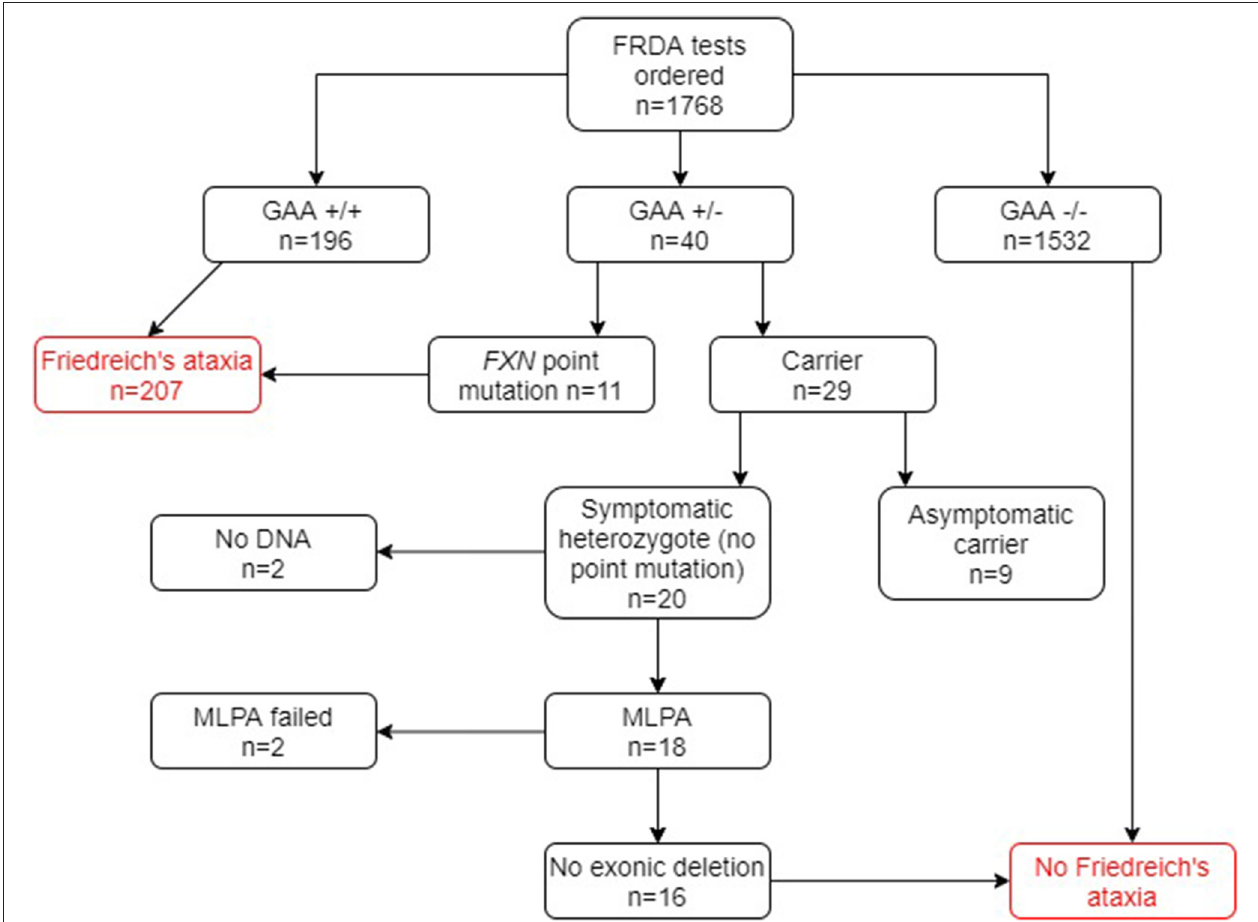
FIGURE 3 | Flowchart summary of genetic results in group B patient cohort. Out of 1,768 patients, 207 patients tested positive for FRDA. GAA + / + two GAA expansions; GAA + / − one GAA expansion; GAA − / − no GAA expansions. MLPA, multiplex ligand-dependent probe amplification.